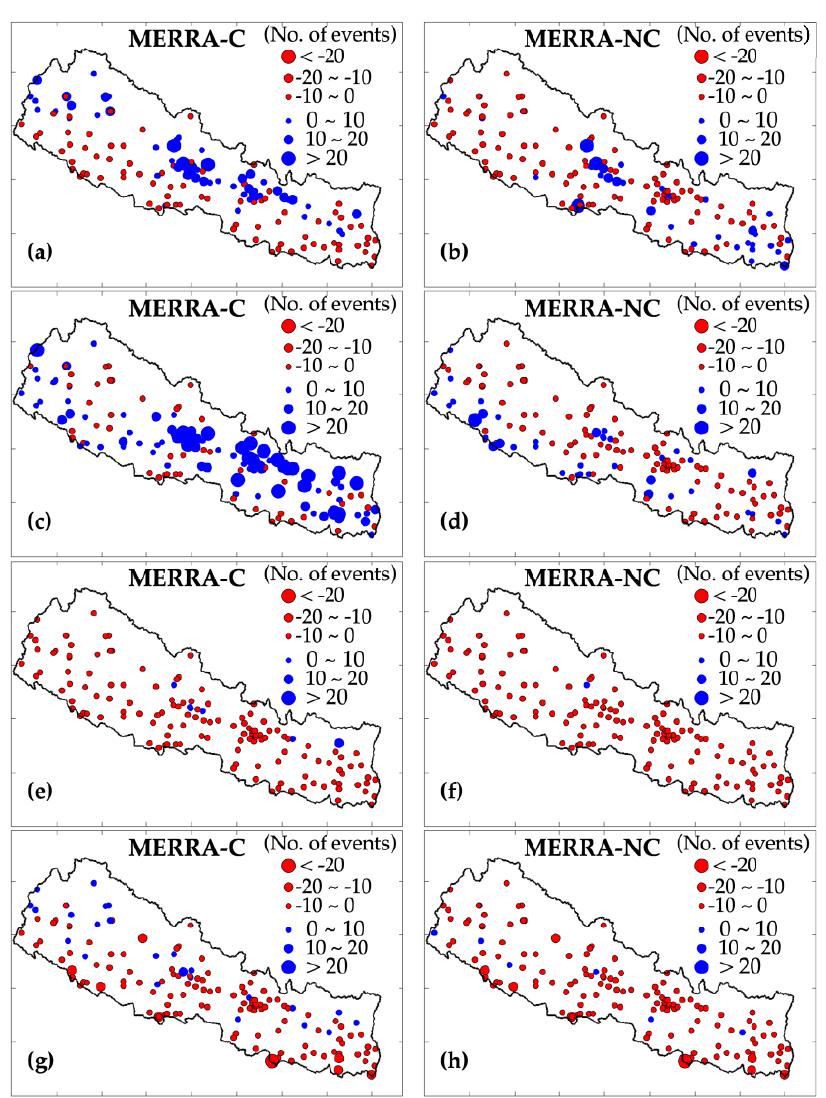
Figure 9. Spatial distribution of bias in very wet events (R5p) at each station for ( a , b ) pre-monsoon, ( c , d ) monsoon, ( e , f ) post-monsoon, ( g , h ) winter between observed and MERRA-2 datasets, respectively. Red and blue circles represent the underestimated and overestimated of R5p events across the country, respectively.